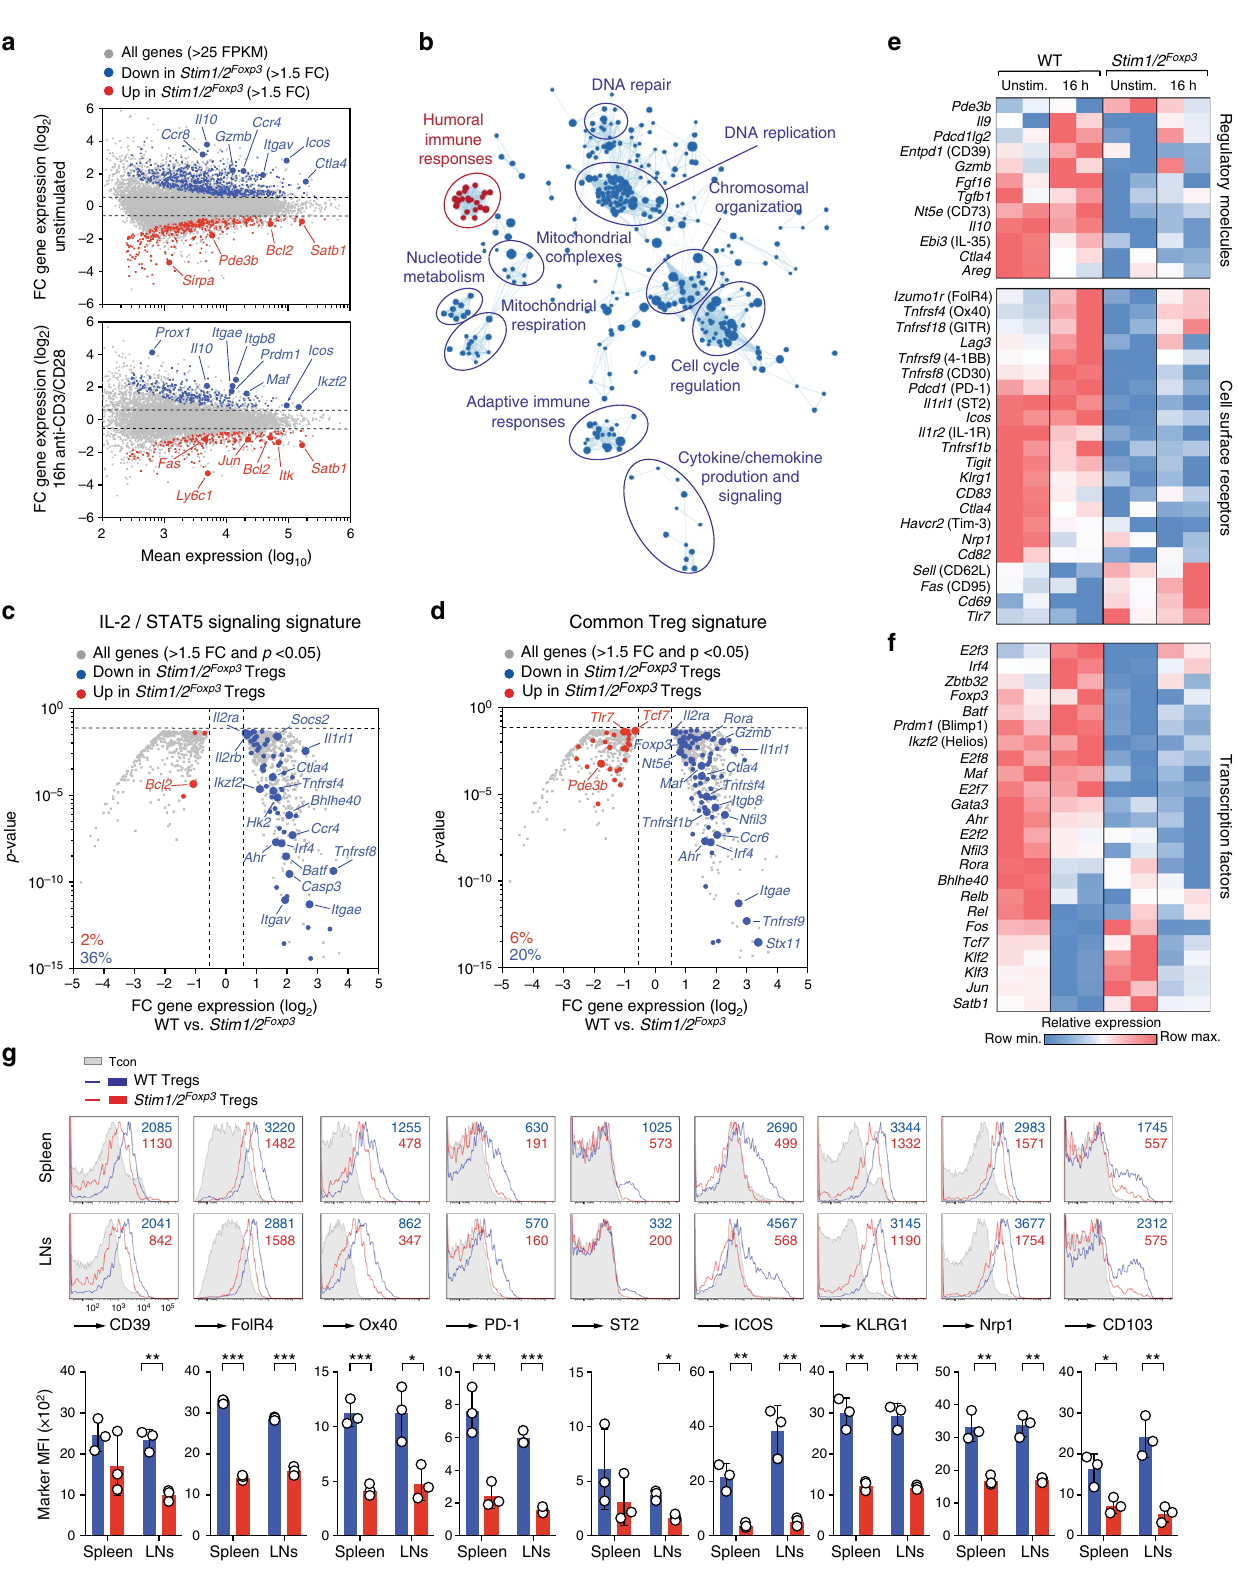
2 – 3 weeks old WT and Stim1/2 Foxp3 mice (Fig. 4j – l). A single injection was suf fi cient to completely eliminate B cells in the blood of WT and Stim1/2 Foxp3 mice as early as 4 days post- injection and for more than 4 weeks (Fig. 4j). Ablation of B cells signi fi cantly increased RBC numbers and hemoglobin levels